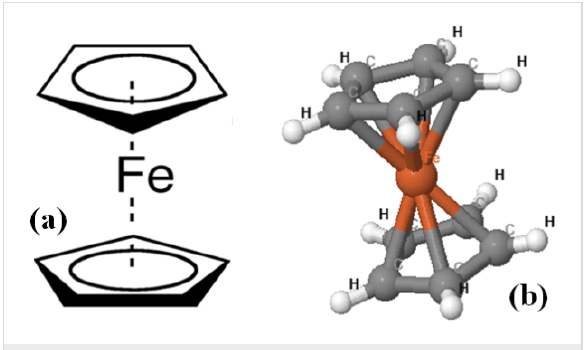
Figure 1: Ferrocene molecular structure (a) and its view as a 3D model